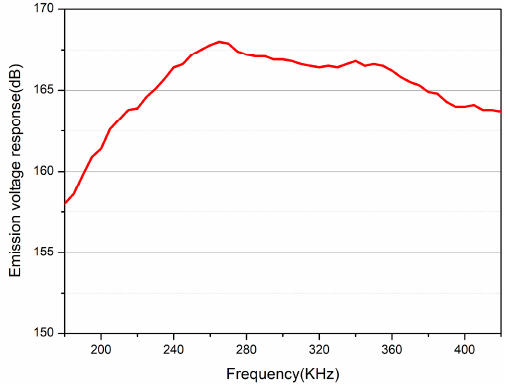
Figure 14. The emission voltage response curve of transducer in the water.